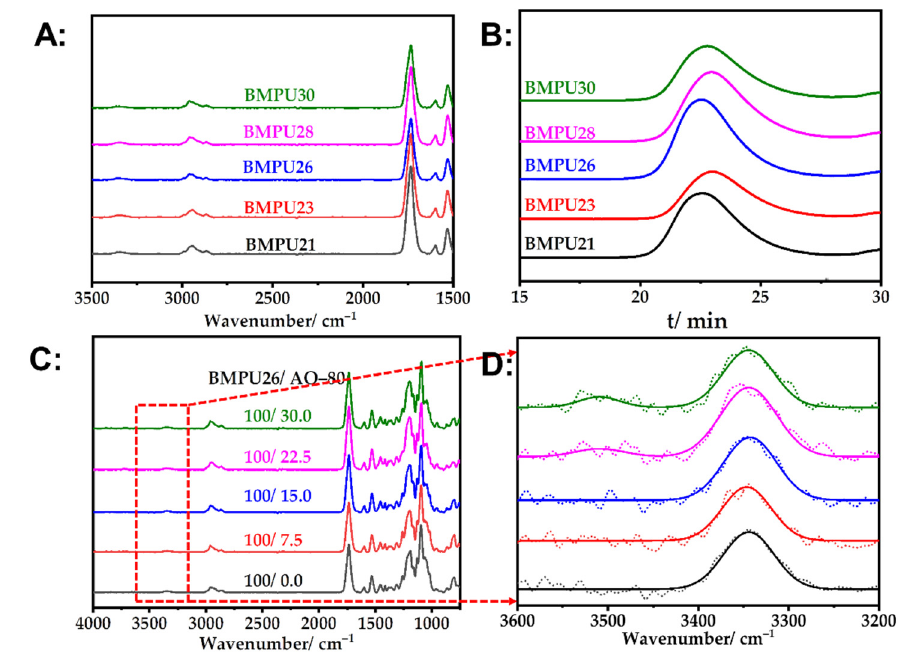
Figure 1. ( A ) FTIR spectra and ( B ) GPC curves of the BMPUs. ( C ) FTIR spectra of the BMPU/AO-80 composites. ( D ) Original and multipeak fitted FTIR spectra of the BMPU/AO-80 composites in the 3280–3610 cm − 1 region.